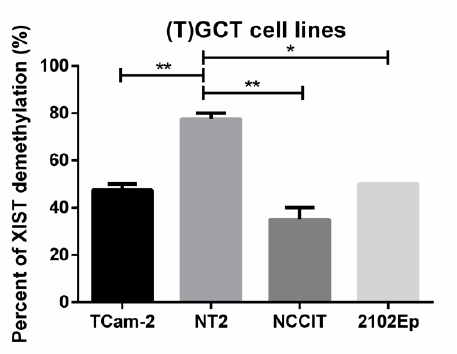
Figure 7. Demethylated XIST fragment percentage in germ cell tumor cell lines. ** indicates p < 0.01 and * indicates p < 0.05. Abbreviations: TGCT—testicular germ cell tumor.